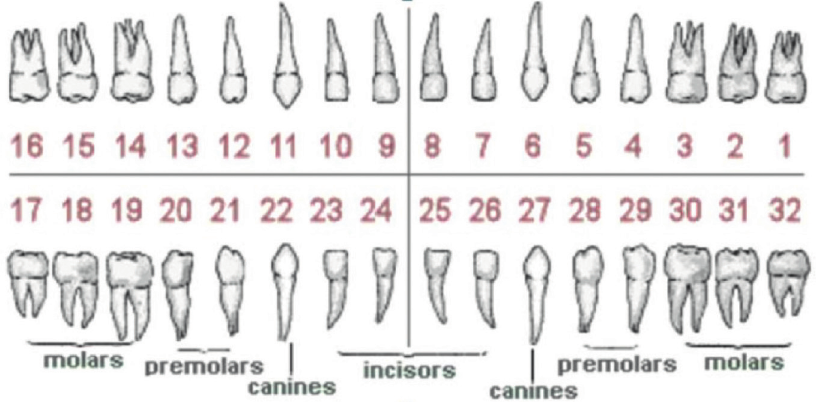
Figure 6: Dental universal numbering system [60].